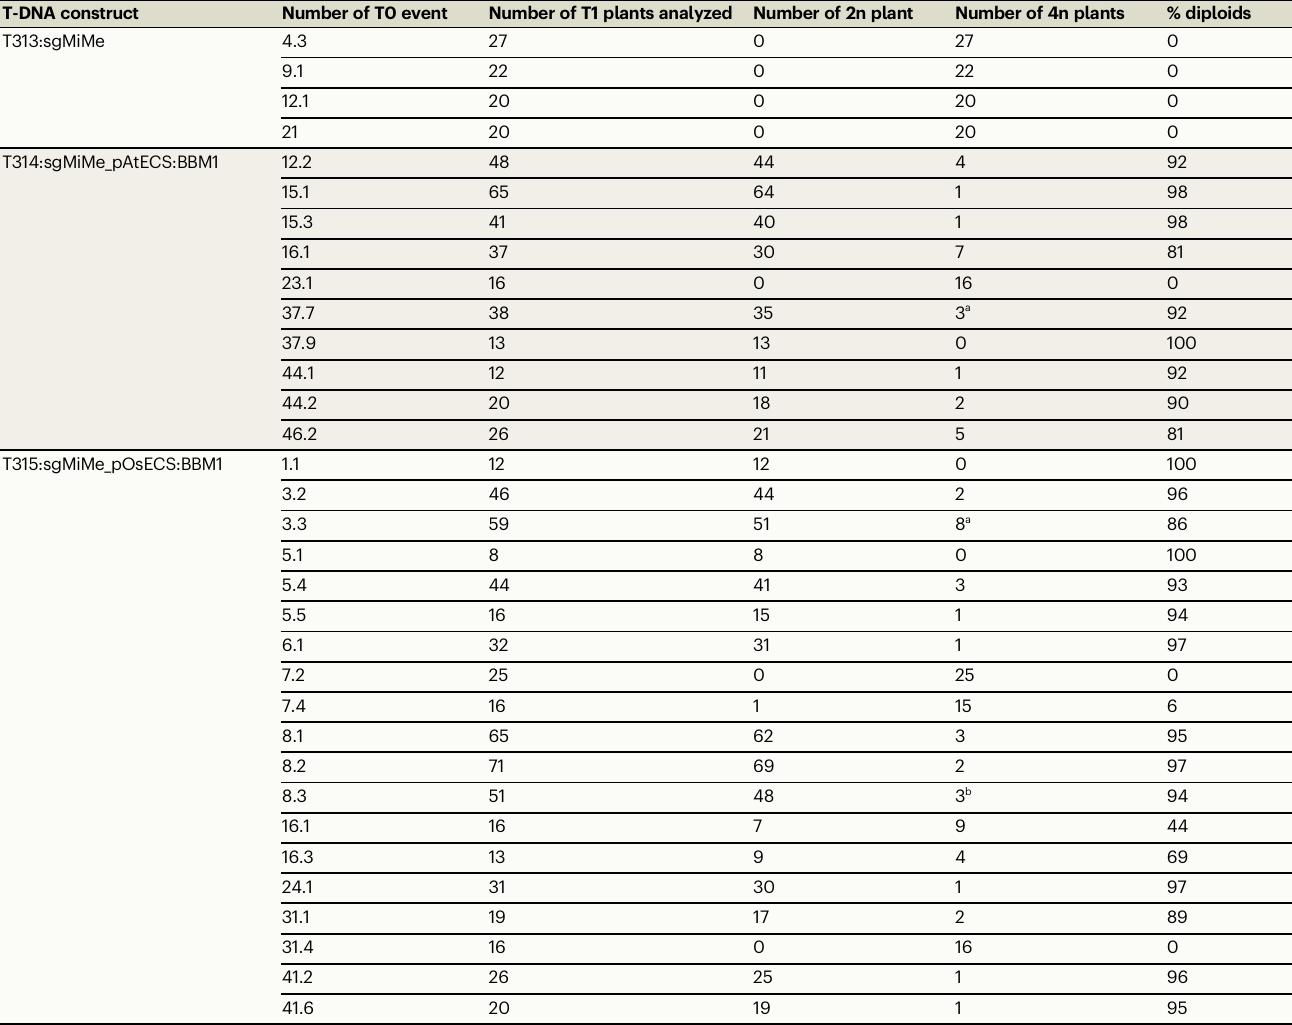
Thepresenceoftheeggcell-speci fi cpromoter:BBM1cassettewasascertainedinalltheT314andT315events.ThenumberofplantsanalyzedvariesaccordingtoT1seedavailability.EventsT31415.1 and37.7and eventsT315 3.2, 5.4,8.1, and8.2 wereselectedfor further analysis onthe basisonboth the score andcon fi dence ofdiploid frequency. a Includes one 2n/4nchimeric